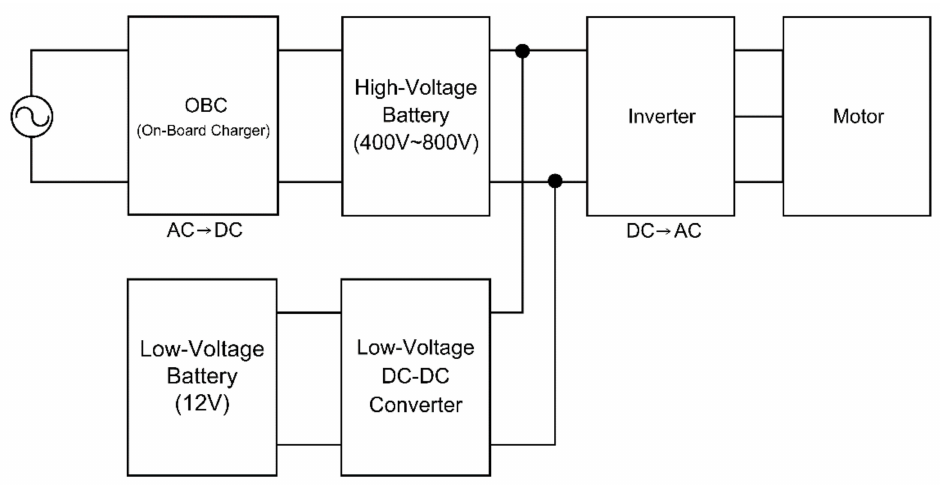
Figure 2. Power conversion system of